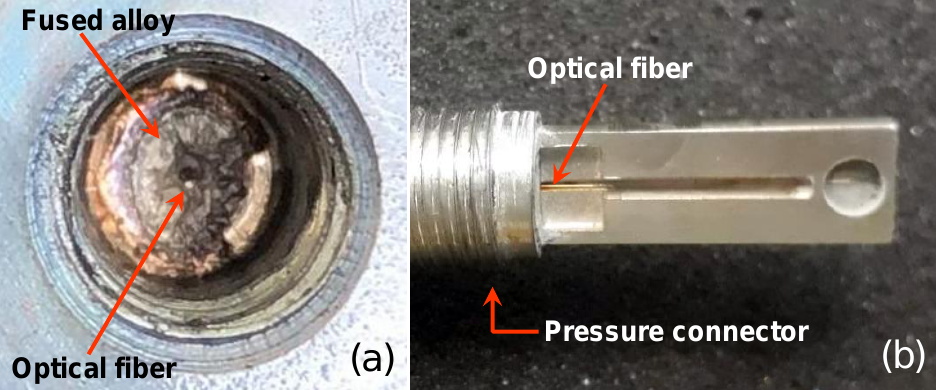
Figure 8. ( a ) Brazing sealing result in the internal part of the pressure connector and ( b ) the external part of pressure connector exhibiting the optical fiber.